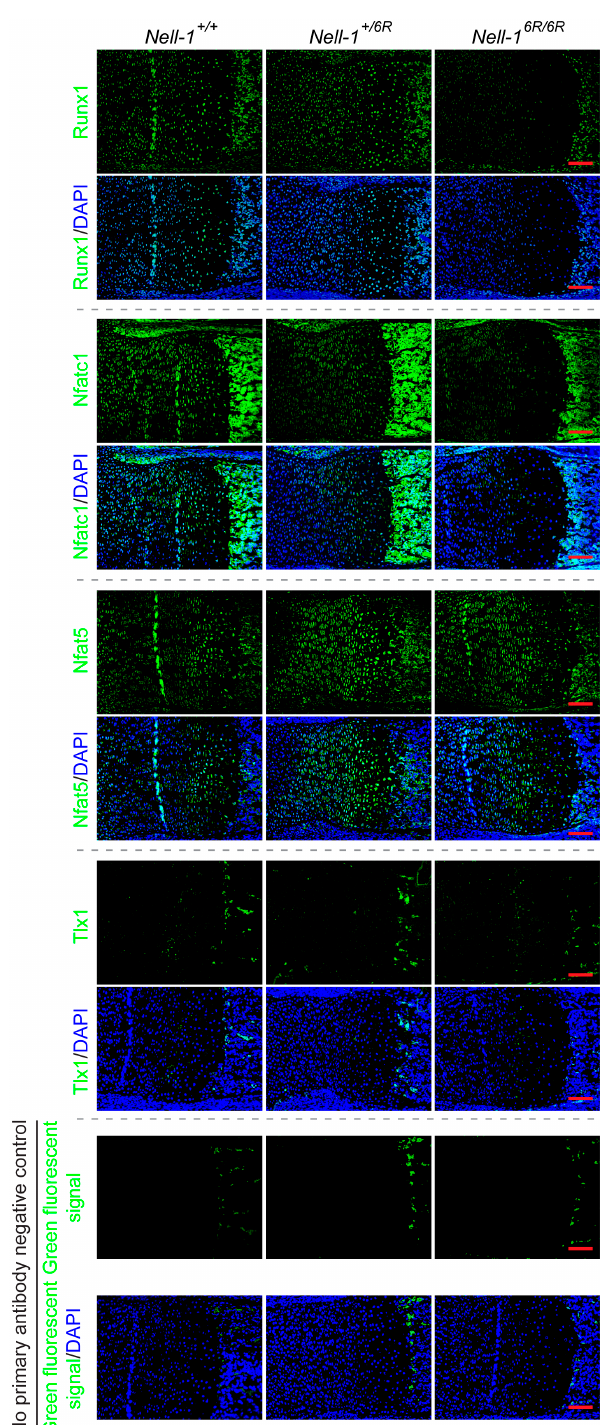
Figure 2. Immunofluorescent (IF) staining of Runx3 -promoter binding transcriptional factor candidates in the femur of neonatal mice with different genotypes of Nell-1. Green, targeted molecule; blue, DAPI counterstaining. In the no primary antibody negative control, the green fluorescent signal was only detected on the red blood cells. Scale bar = 50 µm.